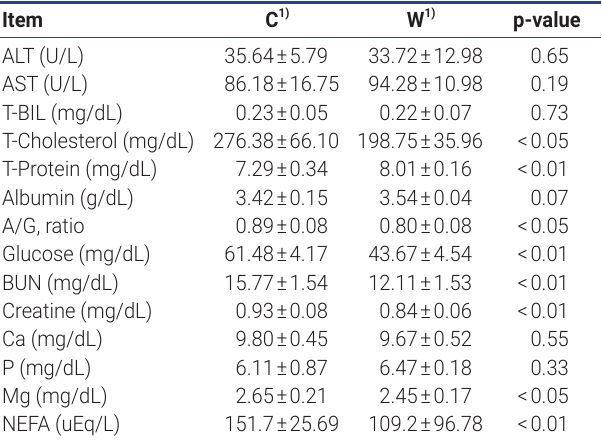
Table 6. Comparison of metabolic profiles between